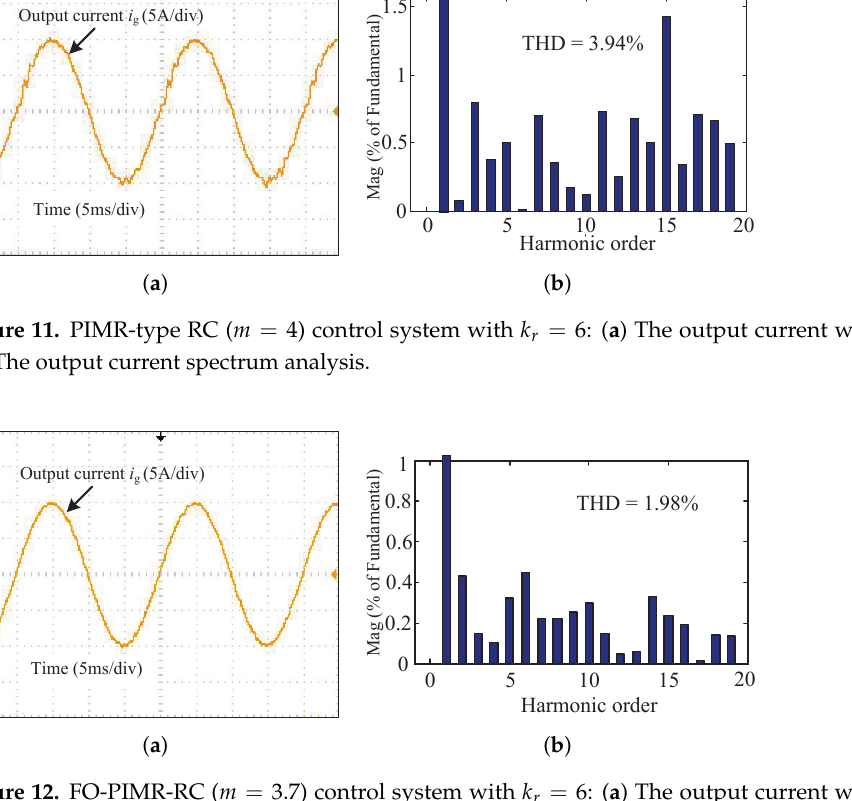
Figure 12. FO-PIMR-RC ( m = 3.7) control system with k r = 6: ( a ) The output current waveform; ( b ) The output current spectrum